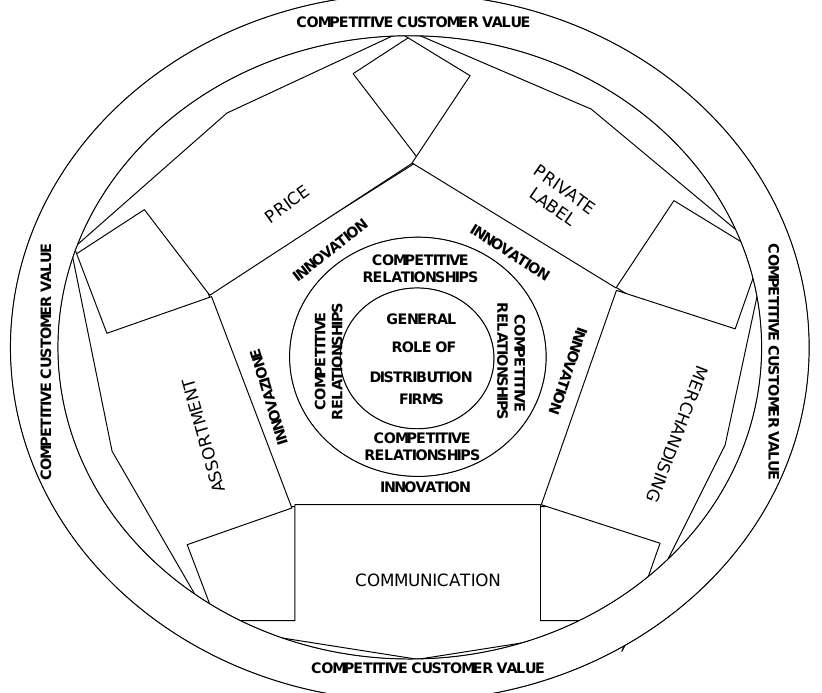
Figure 2: Value Drivers of Large Scale Retail Trade Businesses